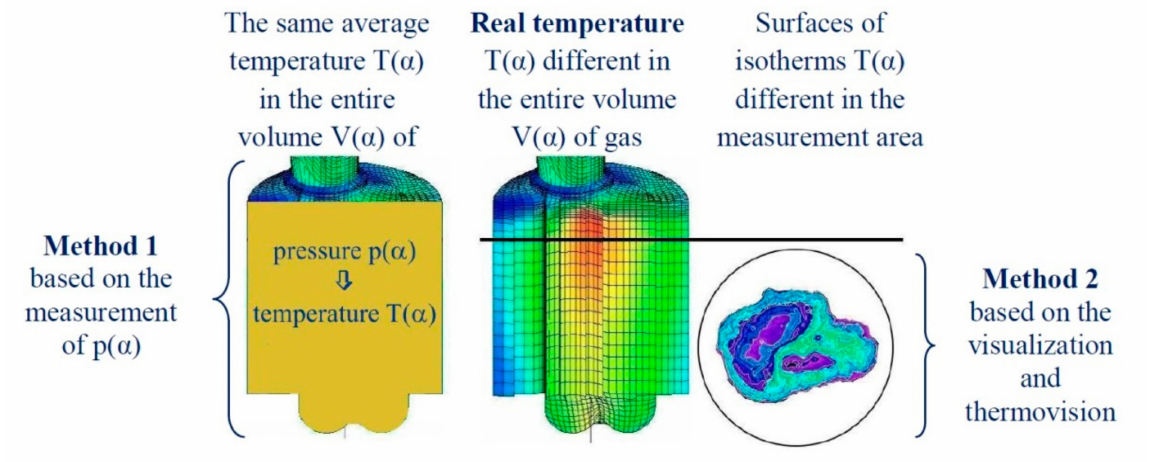
Figure 1. Methods of determining combustion